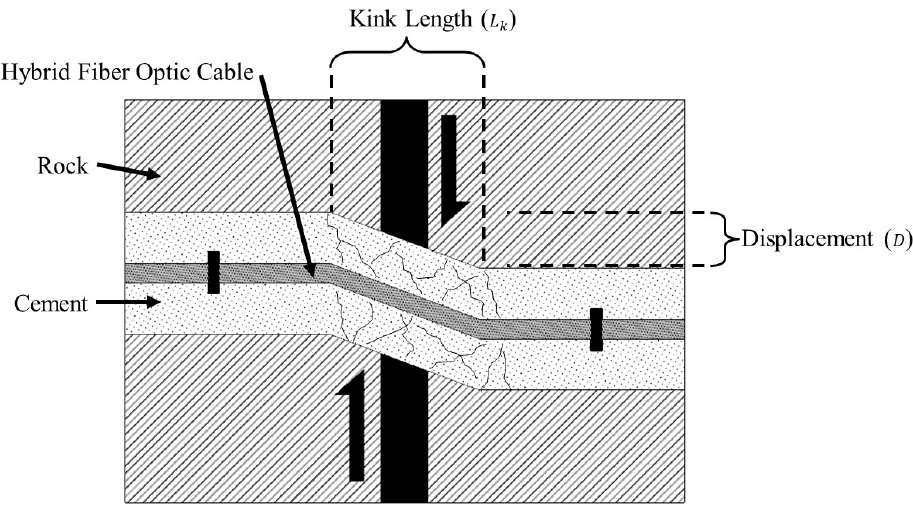
Figure 4. Development of a deformation zone within a cemented borehole in response to shear displacement along a discontinuity, characterized by the kink length. Note: while the kink length can be used to describe the total strain applied to the optical fiber, the strained length of the optical fiber is determined by the gauge length between anchoring points.